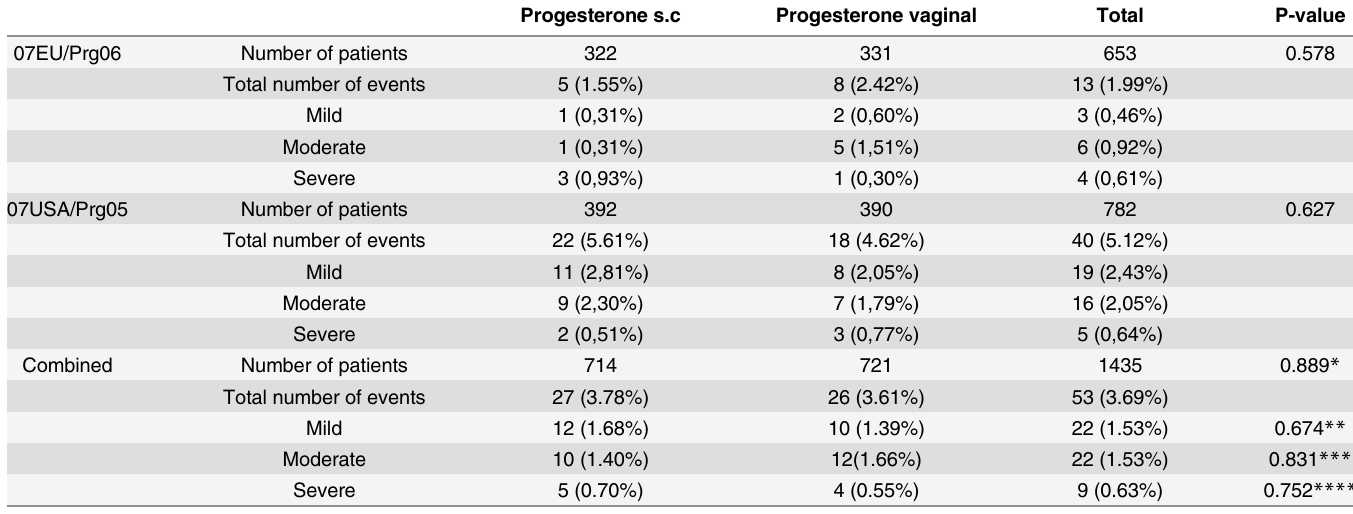
Table 4. Incidence of OHSS by grade in the two trials and